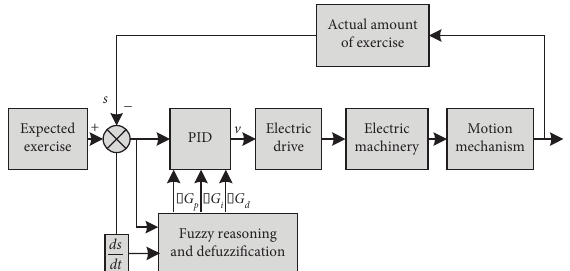
Figure 3: Fuzzy PID control block diagram of line changing